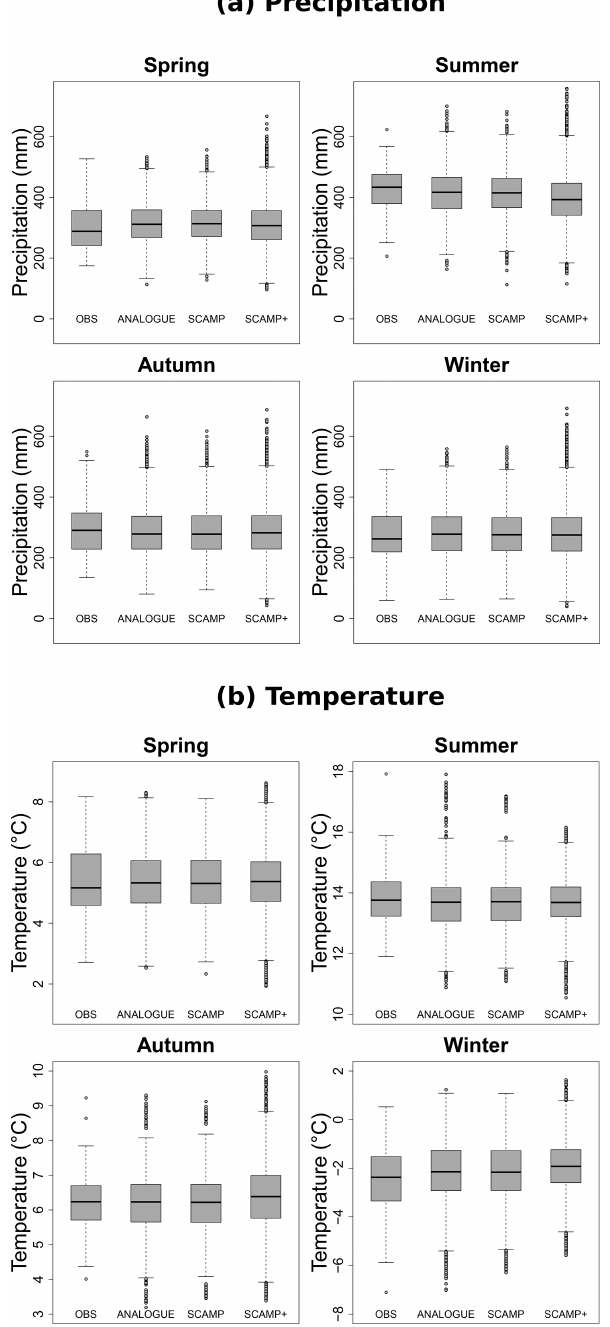
Figure 7. (a) Observed and simulated boxplots of seasonal precip- itation amounts for ANALOGUE, SCAMP and SCAMP + (spring: